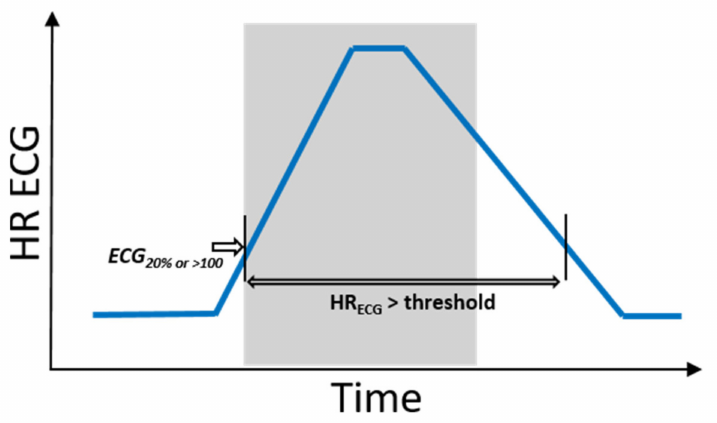
Figure 4. Schematic illustrations of a seizure with IT and corresponding time interval during which, based on ECG, IT is measurable. The ictal phase is marked in